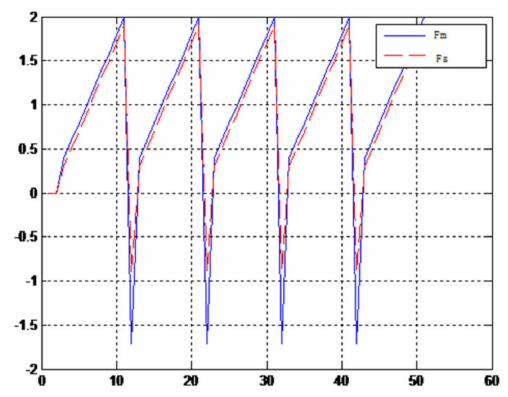
Figure 23. Force feedback wave along x axis. (No time delay, solid ball).